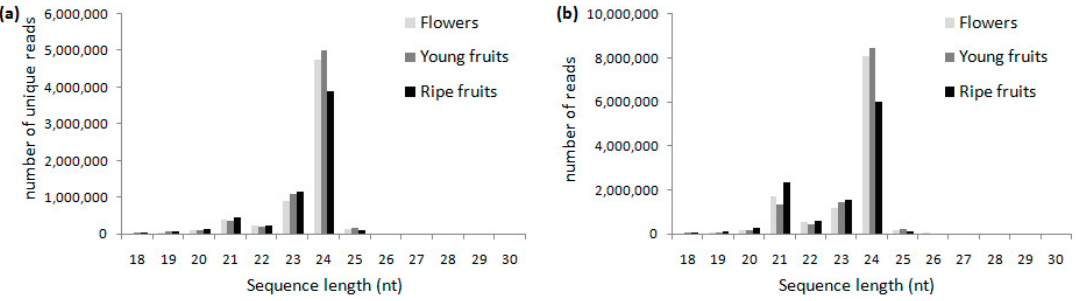
Figure 3. Length distribution of unique sRNAs ( a ) and clean reads ( b ) for V. ashei flowers, young fruits, and ripe fruits.